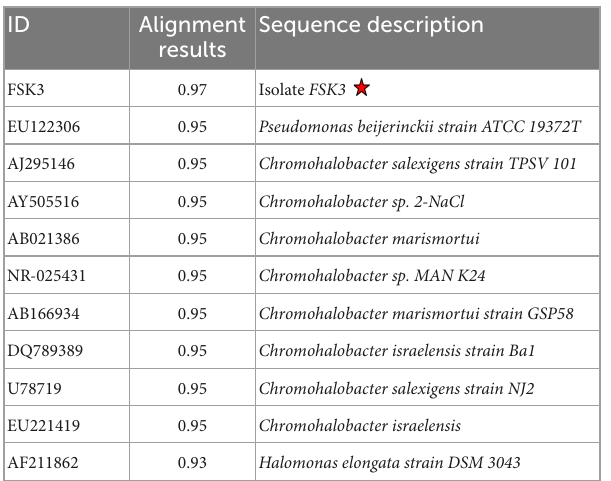
TABLE 3 Alignment view using combination of NCBI GenBank and RDP database.